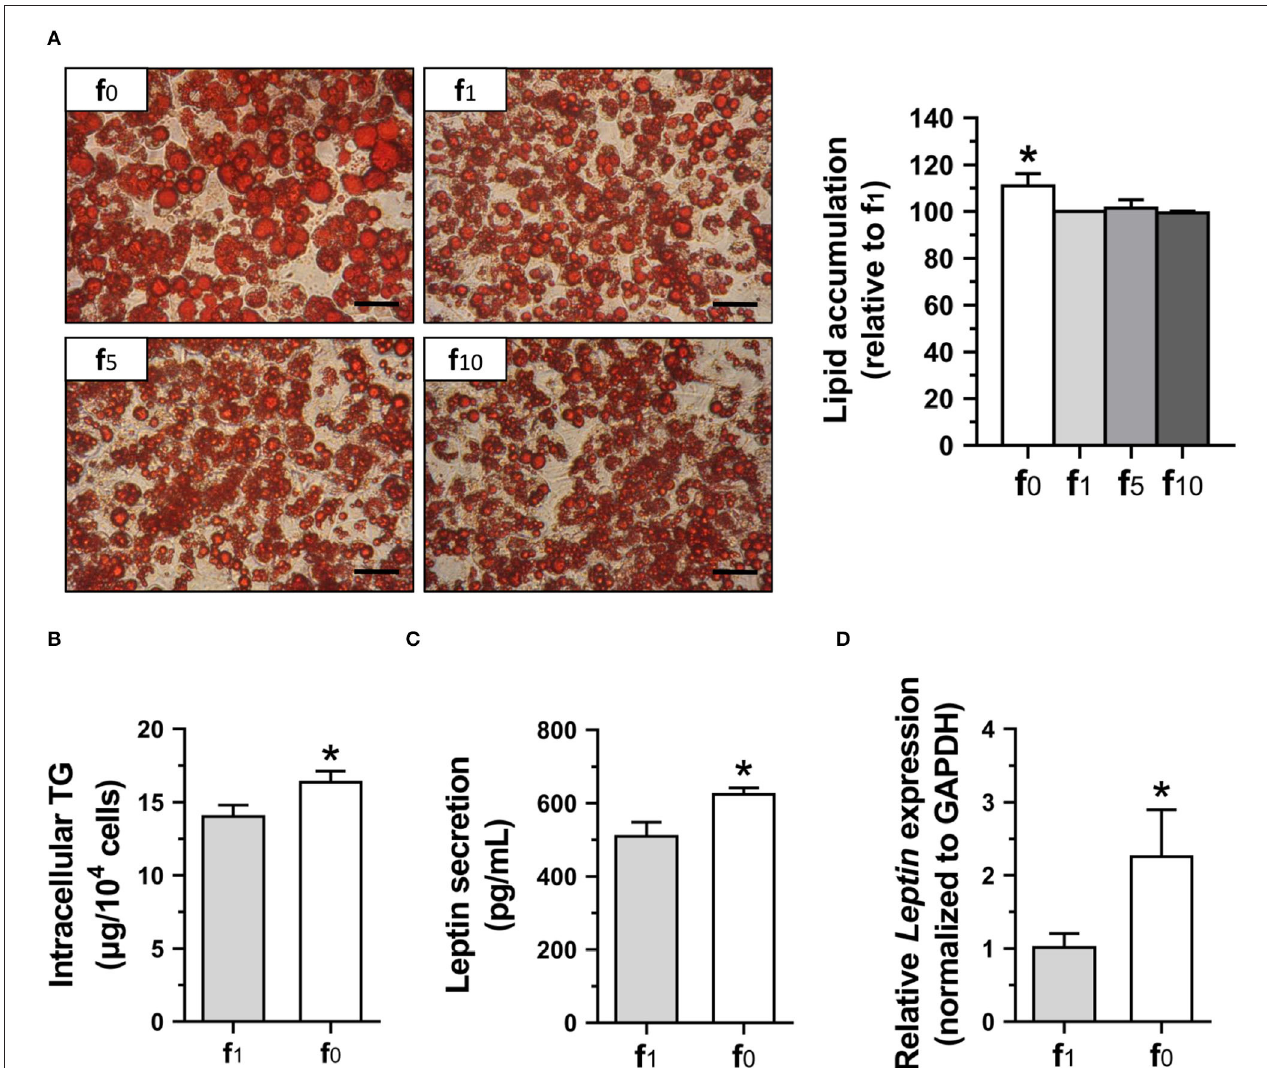
FIGURE 7 | Folate deficiency enhanced lipid accumulation and leptin secretion of 3T3-L1 adipocytes. (A) The representative images of oil-red O-stained adipocytes (scale bar: 100 µ m) and lipid accumulation, (B) intracellular TG content, (C) leptin secretion, and (D) leptin gene expression determined using qPCR assay. Data mean ± SD ( n = 4). * p < 0.01 vs. f 1 group by Student’s t -test.